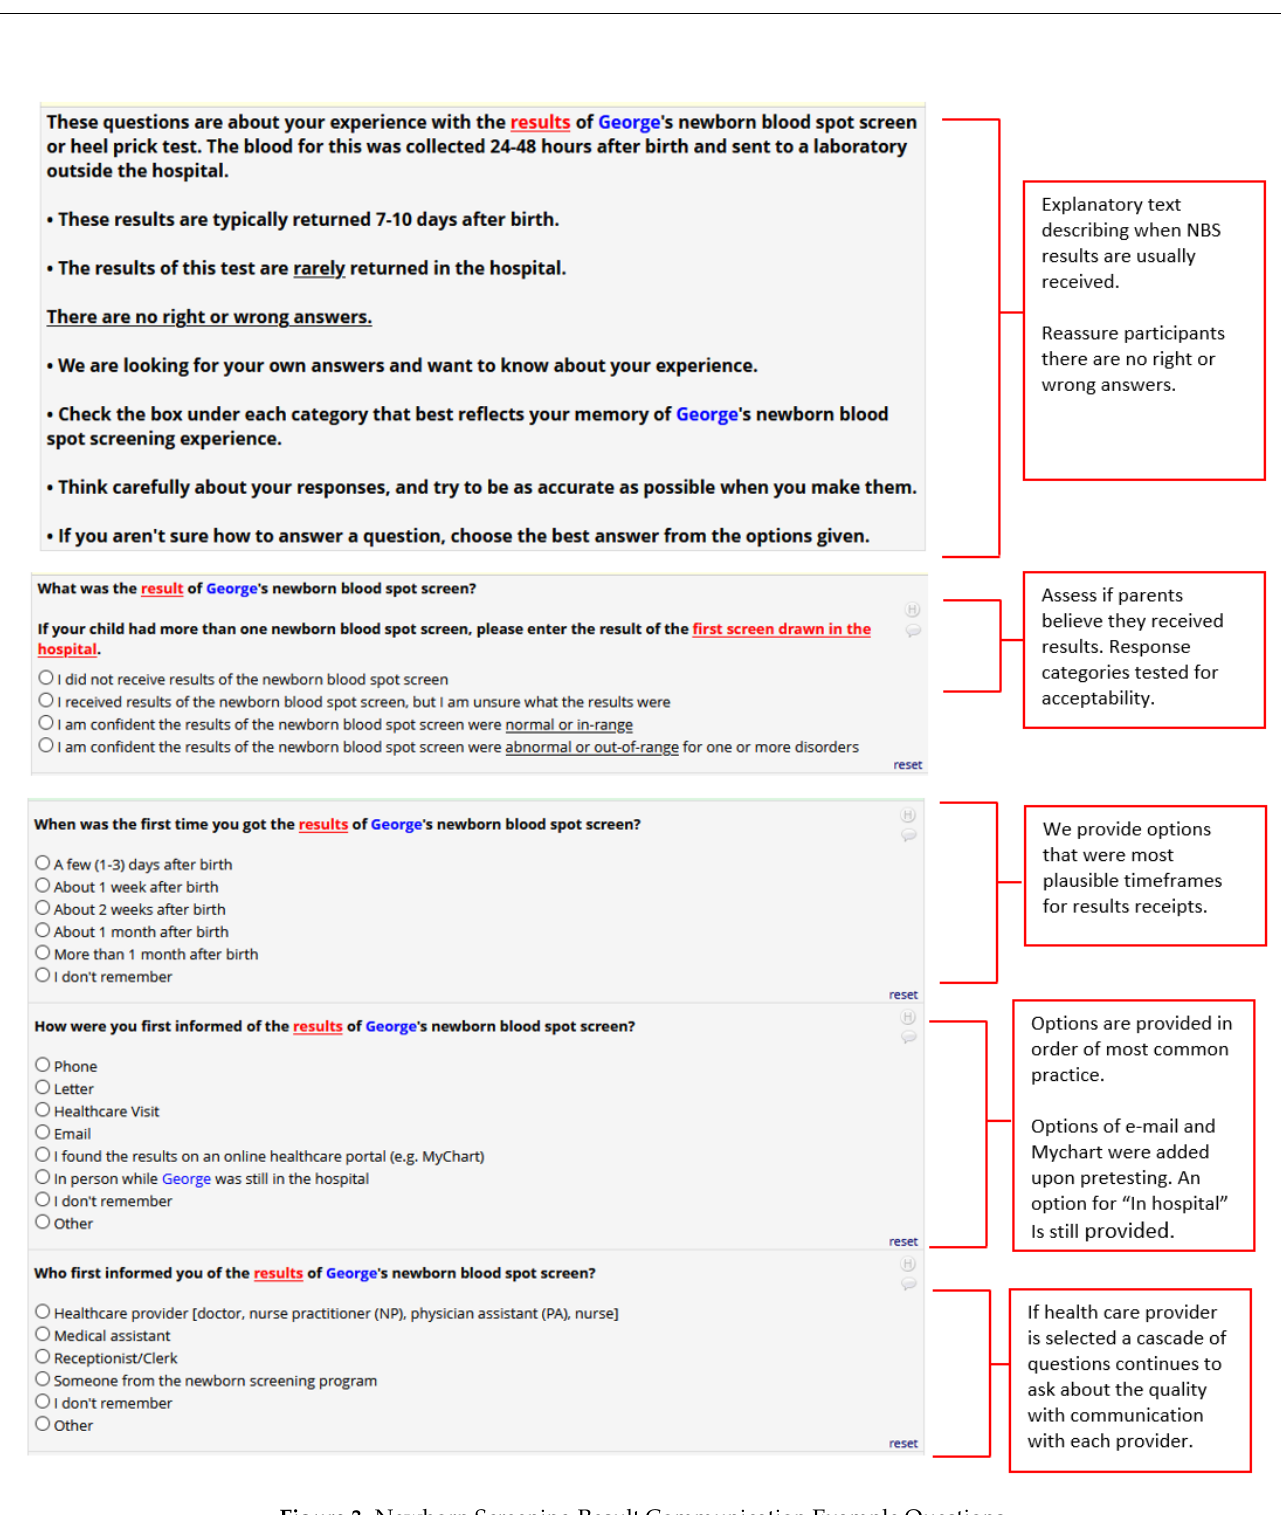
Figure 3. Newborn Screening Result Communication Example Questions.